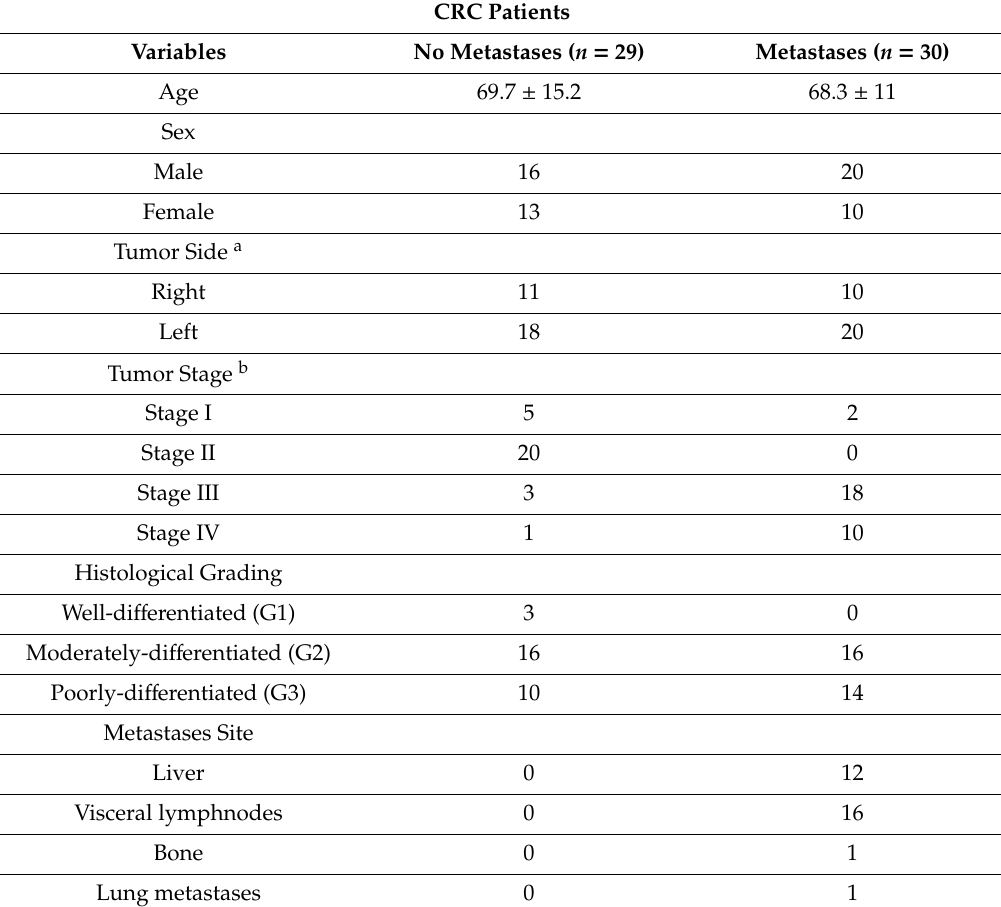
Table 1. Clinical and histopathological features of colorectal cancer patients with and without synchronous